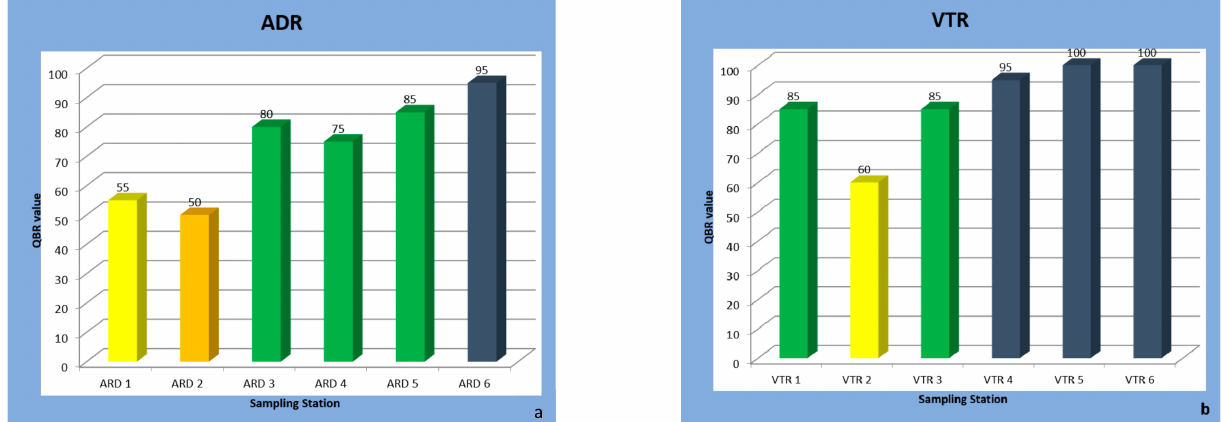
Figure 4. The riparian forest quality (QBR) protocol values for the ( a ) ADR and ( b ) the VTR sampling stations. The blue column indicates that the station is in natural condition, the green in good condition, the yellow in satisfactory condition and the orange in not satisfactory condition.